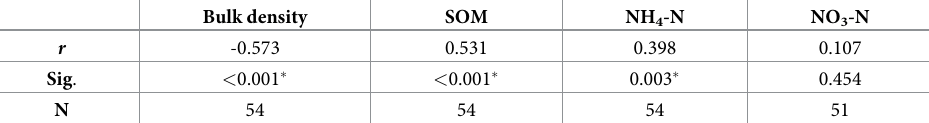
Table 3. Relationship between water content and bulk density, SOM, NH4-N, NO3-N content. The asterisks indi- cate significant correlation at p < 0.01(Spearman’s Correlation Analysis r